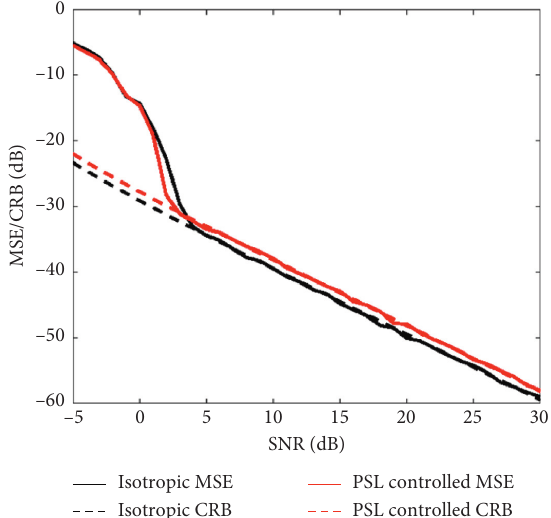
Figure 6: Mean Square Error and Cramer–Rao Bound of type 1 and type 2